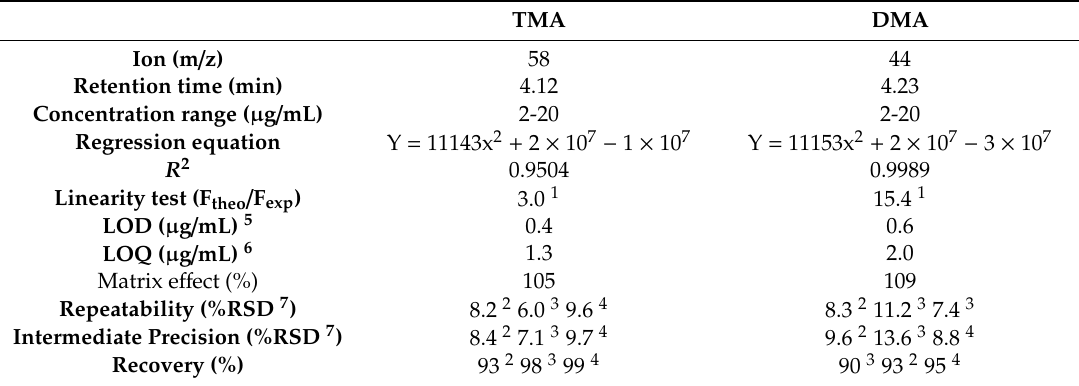
Table 3. Parameters results of the HS-SPME / GC-MS method for quantification of TMA and DMA in fish.